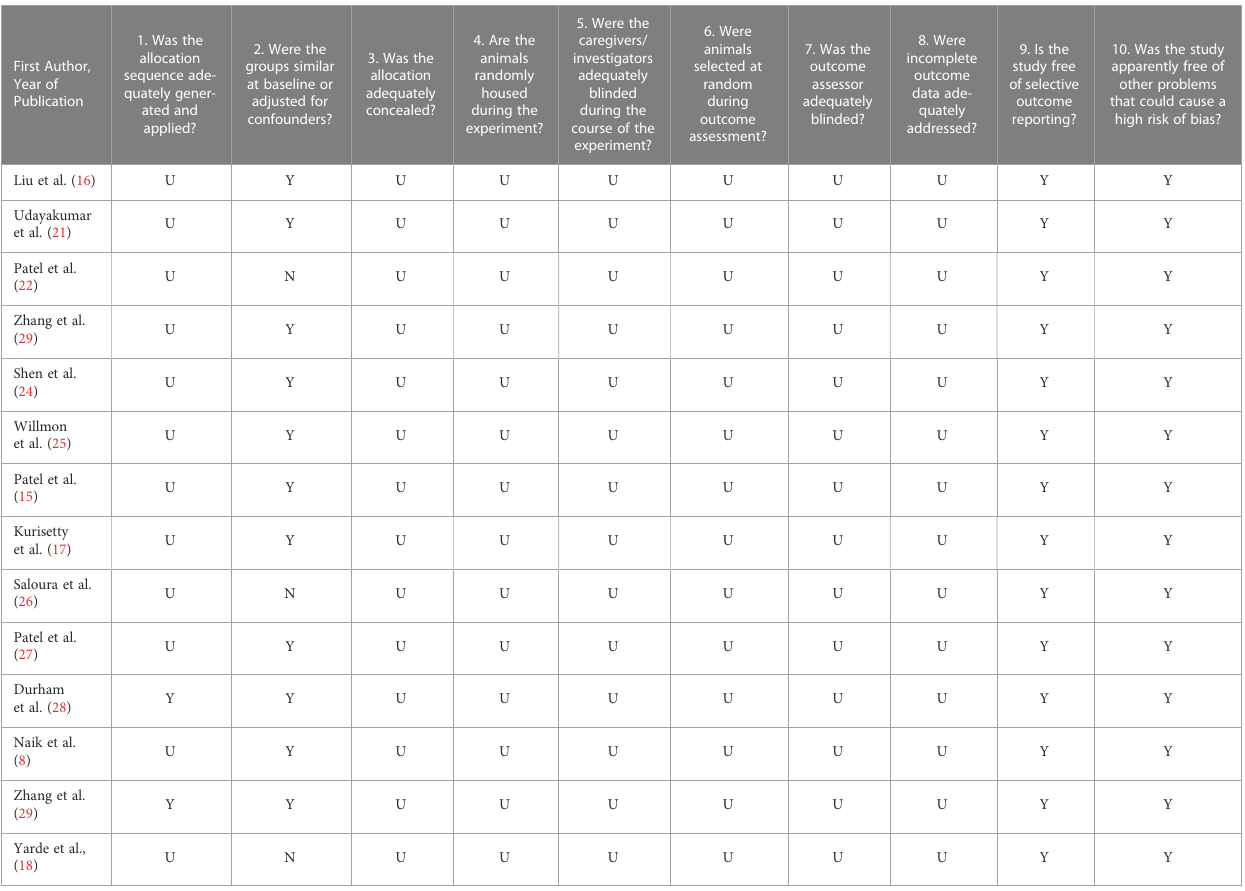
TABLE 2 Assessment of risk of bias using SYRCLE ’ S risk of bias